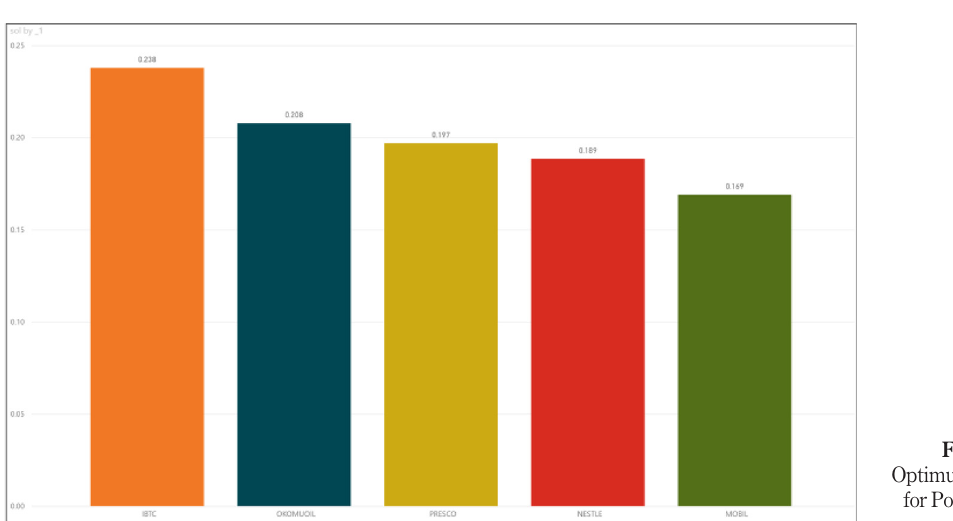
Figure A14. Optimum allocation for Portfolio mix B